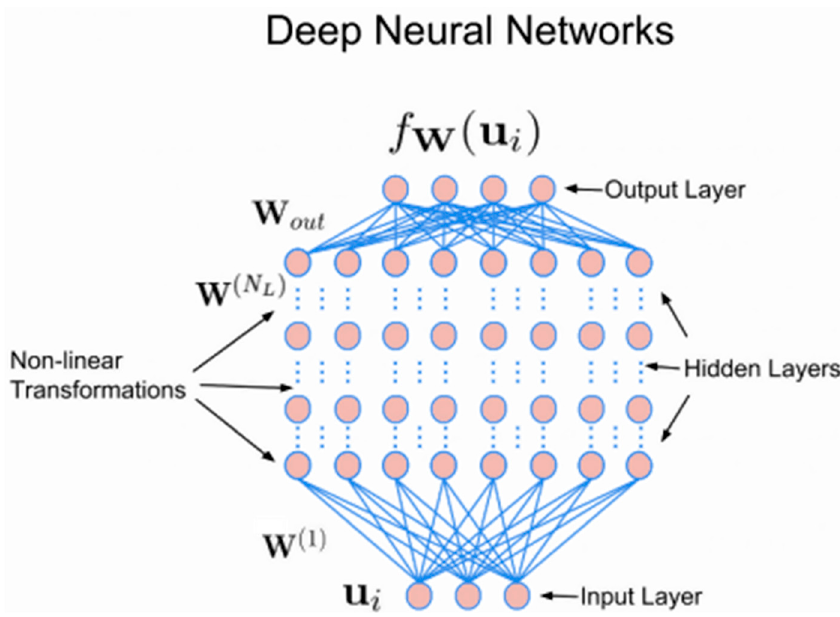
Figure 2. The architecture representation of a deep neural network [23].